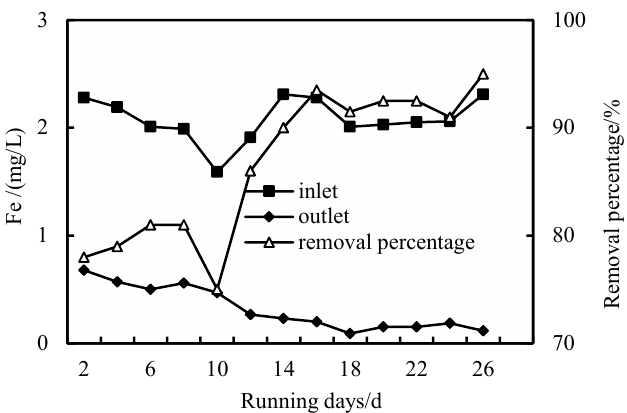
Figure 10. Removal of Fe with PAC-HUM.